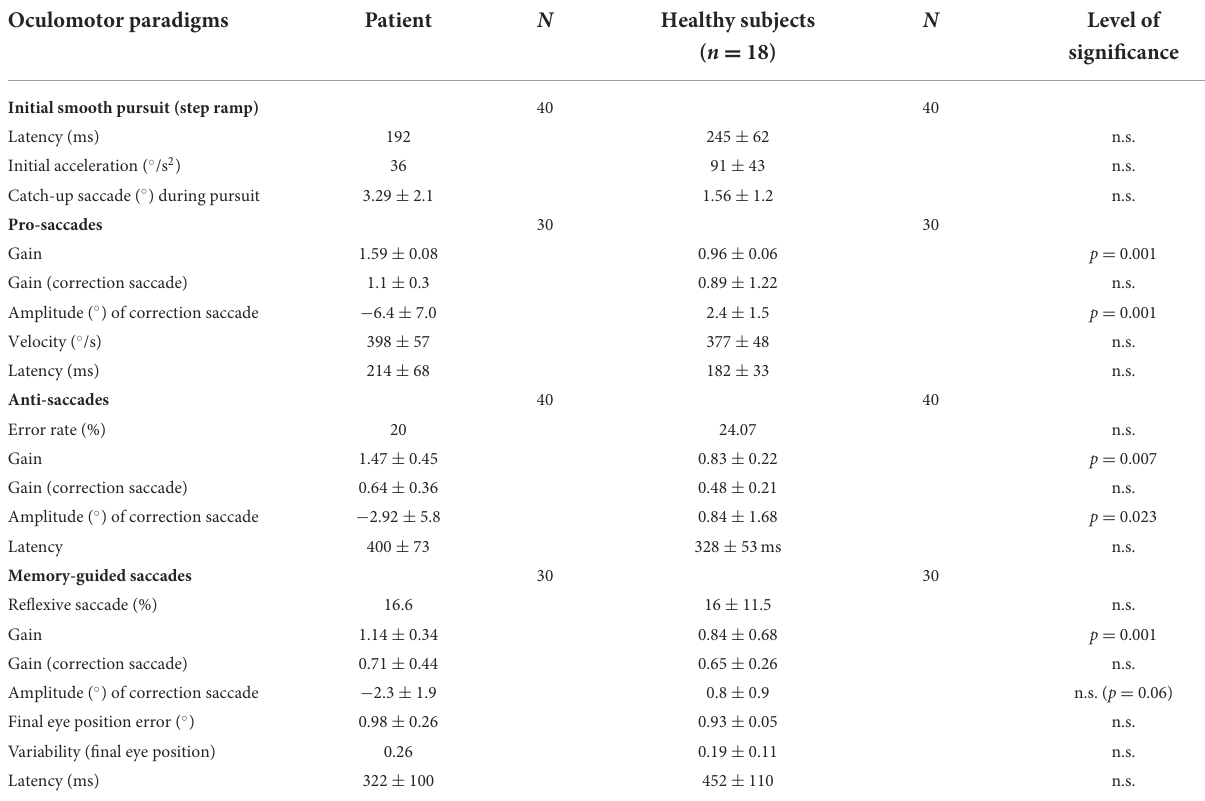
TABLE 1 Horizontal eye movementparameters of the patient and the healthy subjects, with the mean (patient) and the mean ( ± standard deviation) of the median of the healthy subjects, the number of measurements (N), and the level of statistically significant differences. Oculomotor paradigms Patient N Healthy subjects N Level